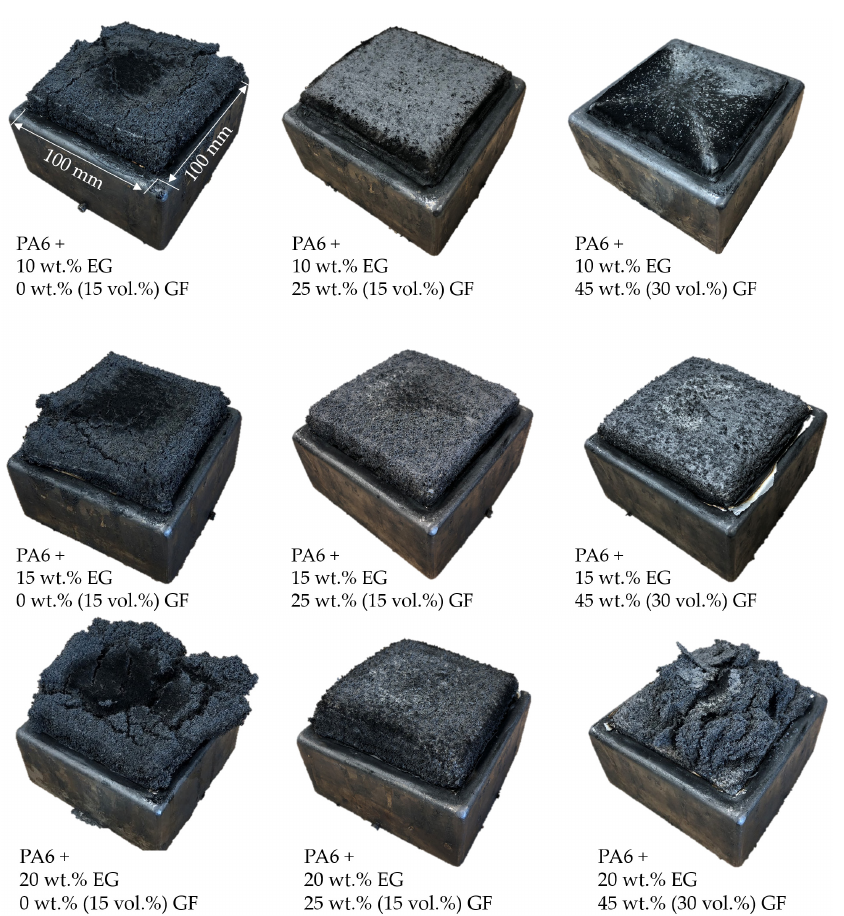
Figure 9. Decreasing residue volumes for higher GF contents in PA6/EG/GF formulations. Cone calorimeter residues after testing at 50 kW/m 2 , presented for non- reinforced and reinforced PA6 at different EG and GF filling degrees.